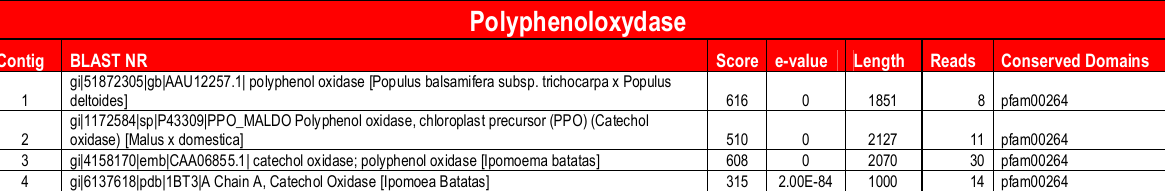
Table S12: EST-Contigs with e-value < e -20 and score > 100 obtained in the Project Polyphenoloxydase, and their blast hit, score, e-value, size, number of reads, and conserved domains from putative